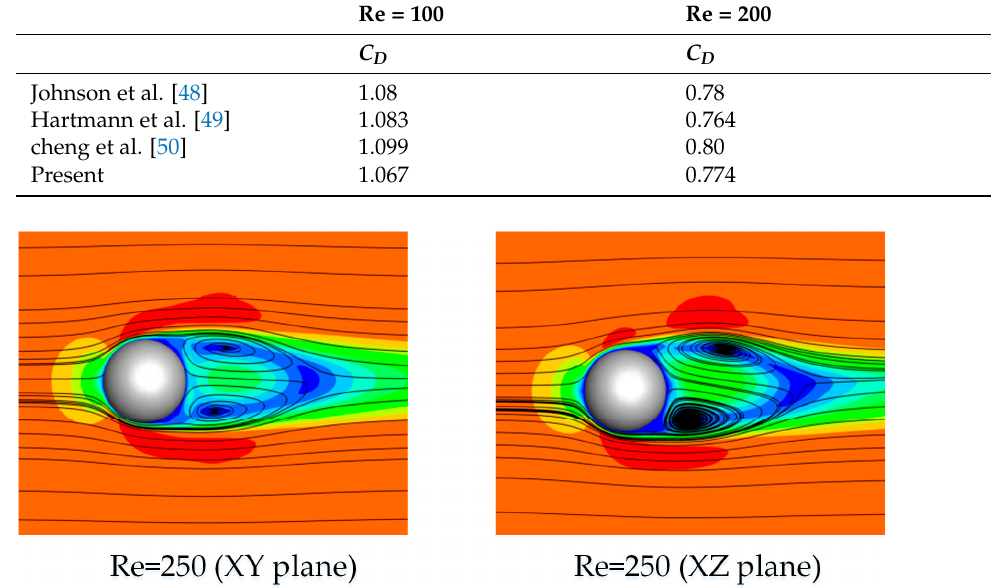
Figure 24. Streamlines and velocity contours for flow past a sphere at Re = 250.